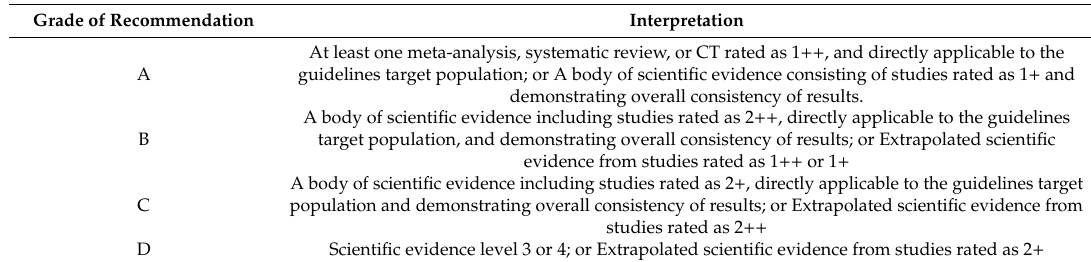
Table 2. Degree of recommendation applicable to each consensus response according to the supporting